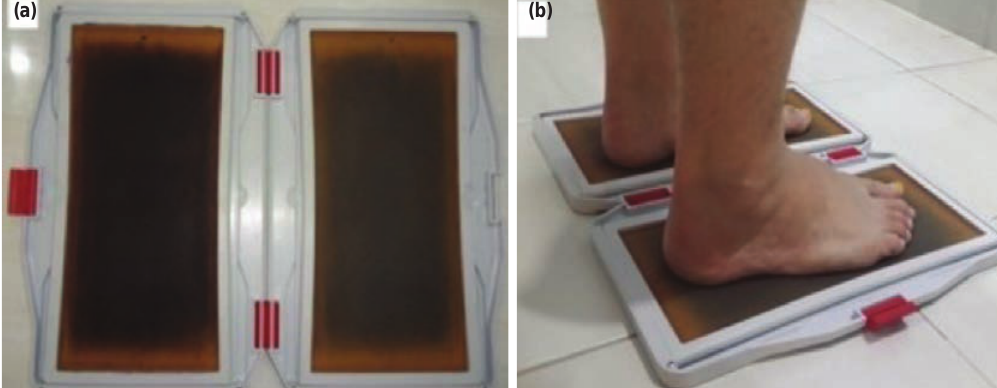
(a). Harris-Beath footprint mat. (b) Acquiring footprint. Fig. 1: